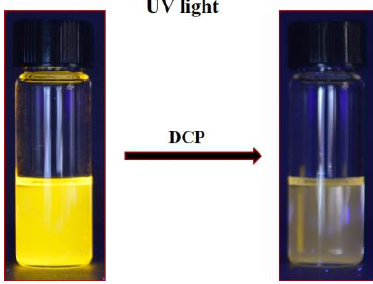
Figure 4. Color change observed on addition of DCP (4 eq.) to a solution of compound 8 in CHCl 3 .